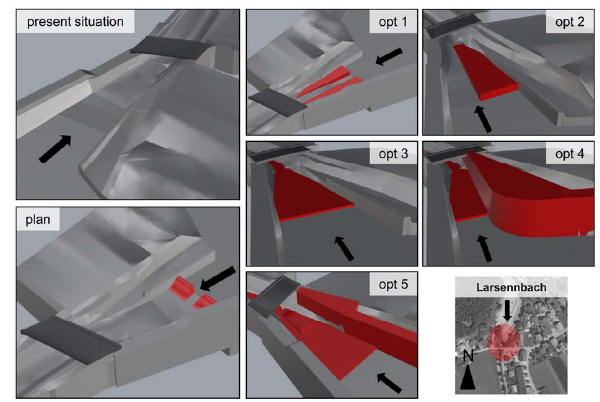
Fig. 4. Situation at the outlet of the deposition basin – present situation and design layouts of the closing-off structure.